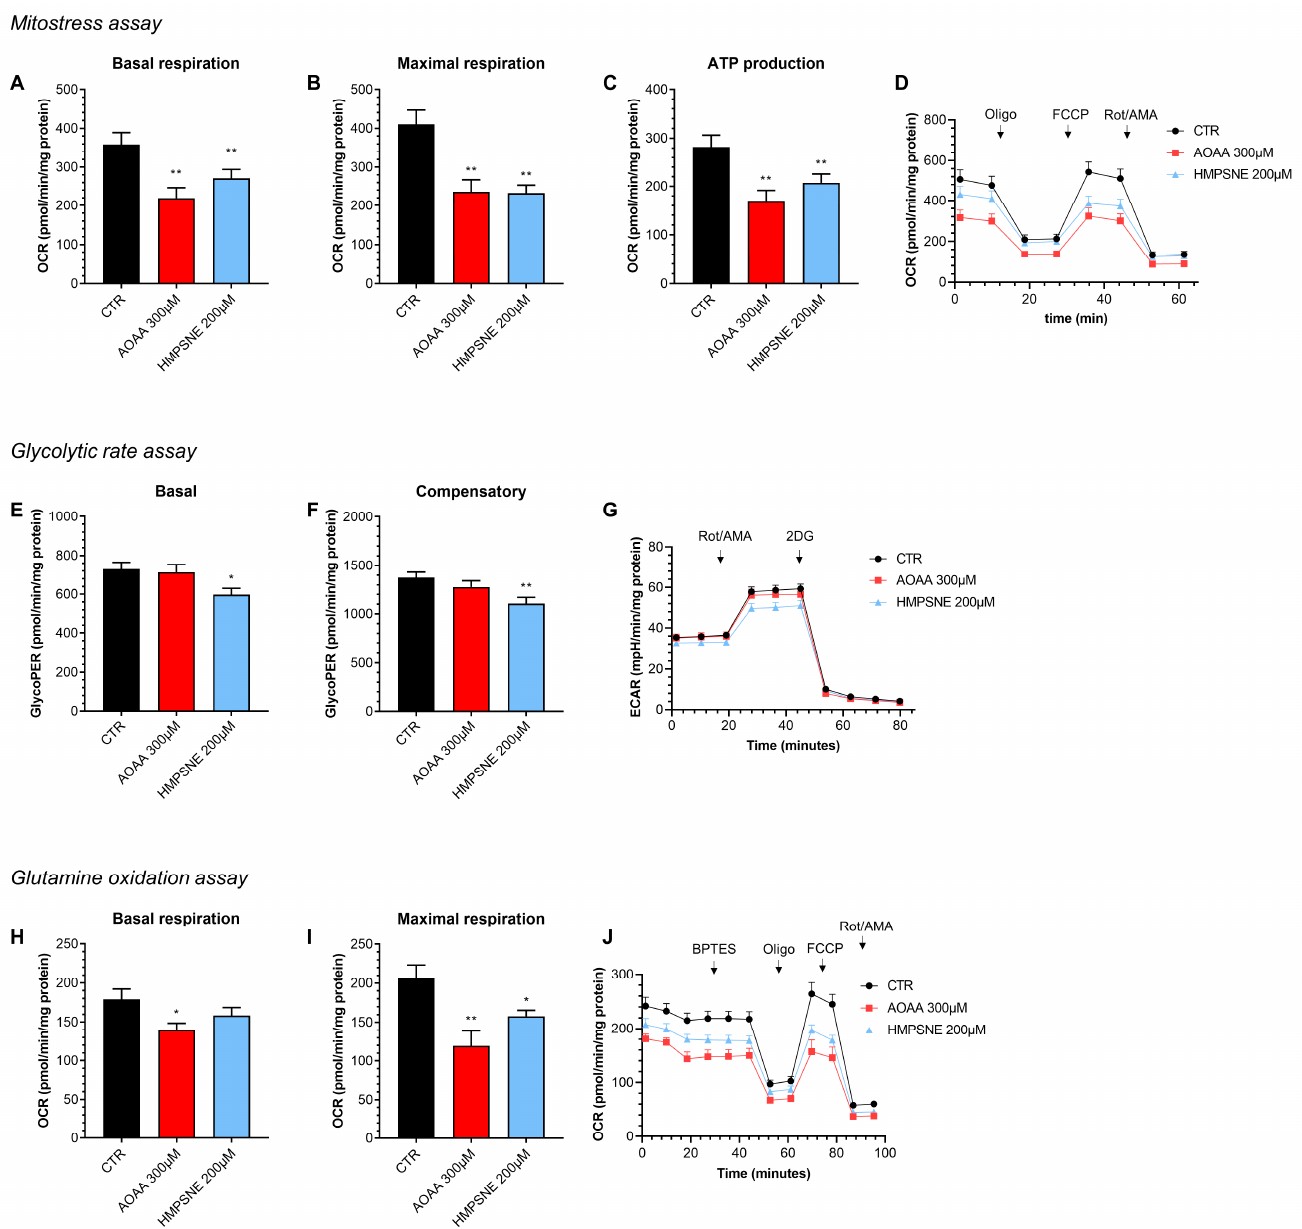
Figure 5. Effect of AOAA (300 µM) or HMPSNE (200 µM) on cellular bioenergetics in EO771 cells.